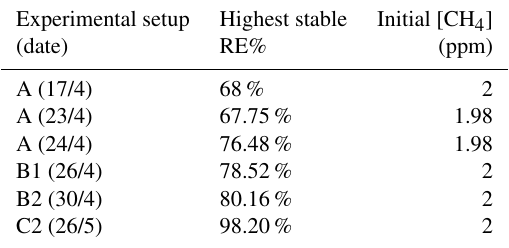
Table A1. Removal efficiencies for the preliminary